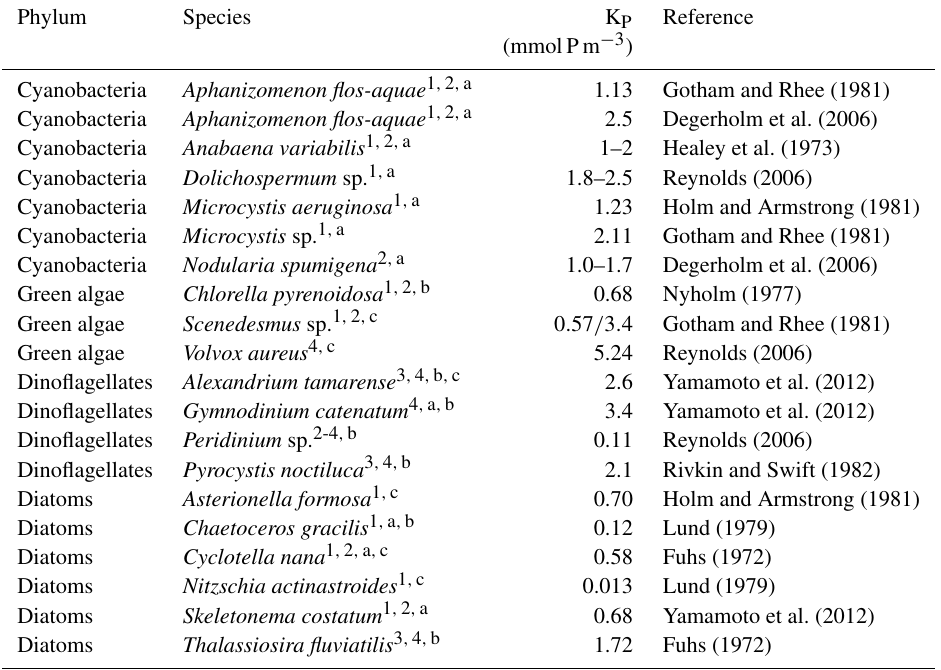
Table 8. Half-saturation constant for phosphate (K P ) for different phytoplankton groups.